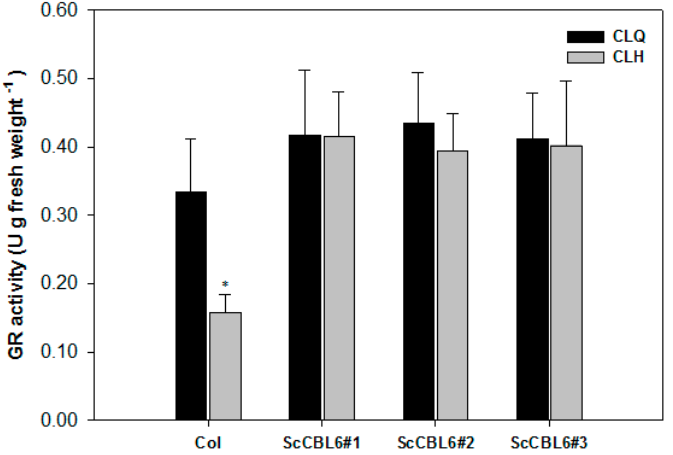
Figure 8. Glutathione reductase activities of the Arabidopsis leaf in response to cold treatment. Asterisk (*) shows significant difference at p < 0.05.